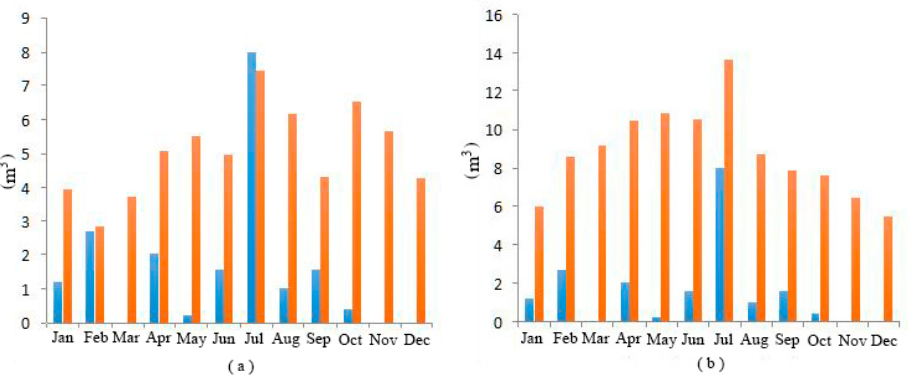
Figure 7. Temporary progression of input (blue) and outlet runoff (orange) in the bioretention cell ( a ) in 1982 and ( b ) in 2010.